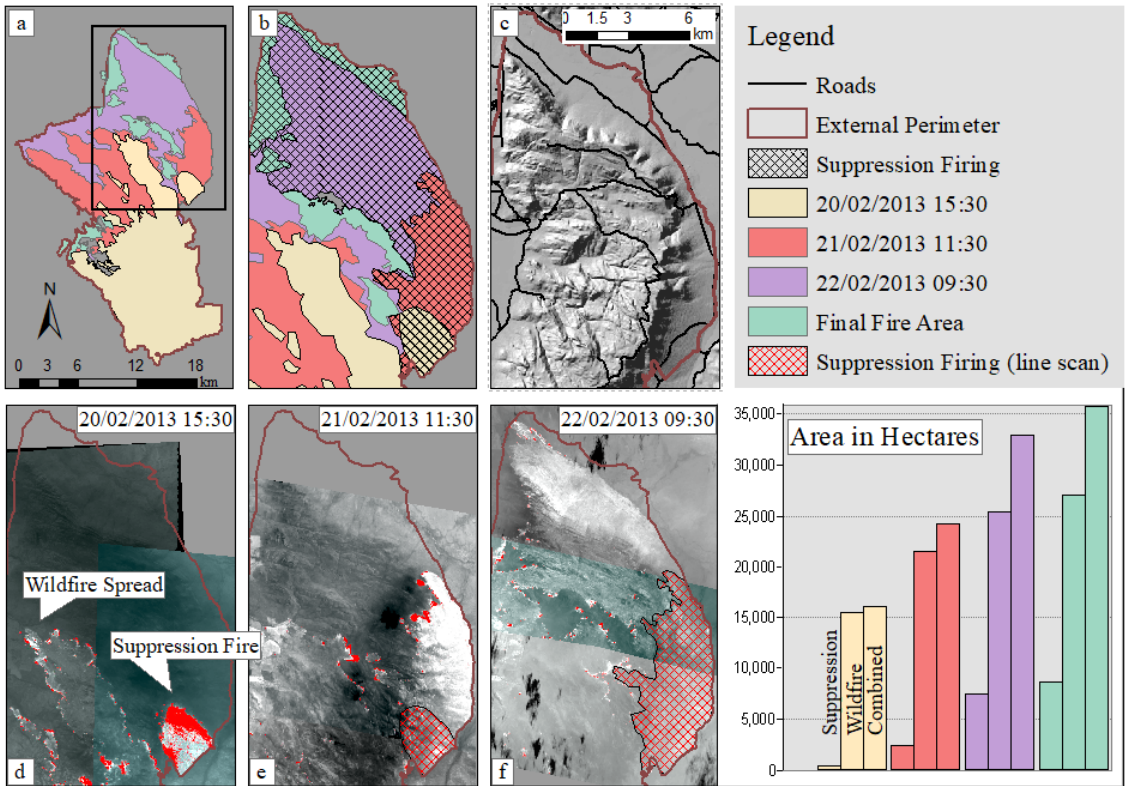
Figure 2. The process of demarcating the suppression firing. ( a ) The final fire area (green) is overlayed with three fire progressions (beige, red, purple). ( b ) The suppression firing area is demarcated with black cross-hatching. ( c ) Hillside shading, roads, and other GIS layers were used to reconstruct the fire spread. The suppression firing area was identified in a series of line scans ( d – f ). Active burning is highlighted by red; recently burnt (still hot) by white; unburnt and cooled areas by grey with shading that varies with topographic features. ( d ) A gap is visible between the suppression fire and the fire, so the suppression firing area can be mapped accurately. ( e ) The suppression firing extends to the north as the fires merge in the south; the red cross-hatched area is suppression firing from the previous scan. ( f ) The suppression firing extends northwest; the previous extent is cross-hatched. As the burnt area cools and the fires merge it becomes increasingly difficult to demarcate the suppression firing. This suppression firing operation burned a total of ~9000 ha. In the final fire footprint, the suppression firing is indecipherable from fire as the remaining gap also burned. The area burned by the (1) suppression firing, (2) wildfire, and (3) combined (sum of suppression and wildfire) is shown in the graph (bottom right), which is colour-coded with each